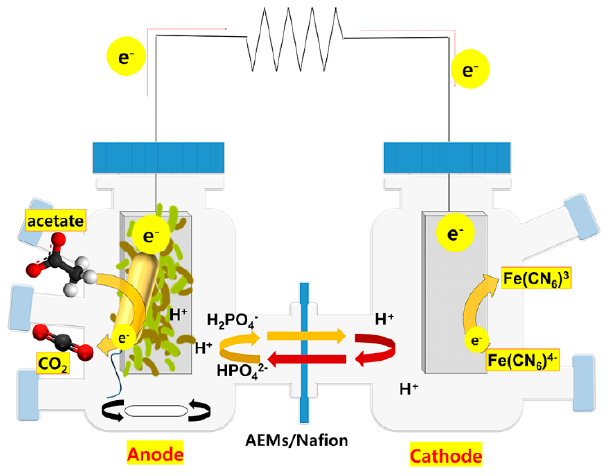
Figure 1. Schematic diagram of a dual-chambered MFC.